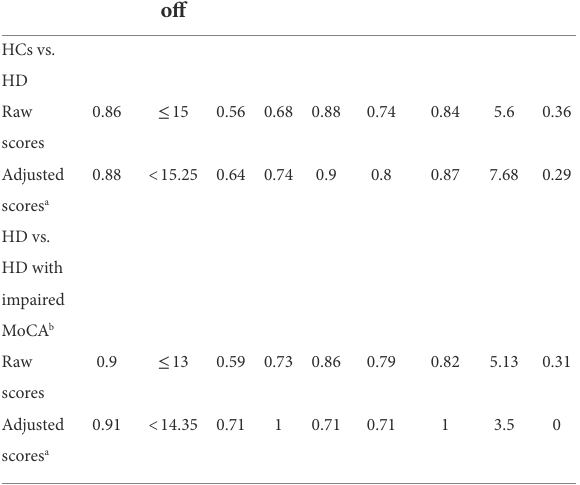
TABLE 2 Diagnostics of the frontal assessment battery (FAB) in case– control and case-finding scenarios as addressed to HD. AUC Cut- J off